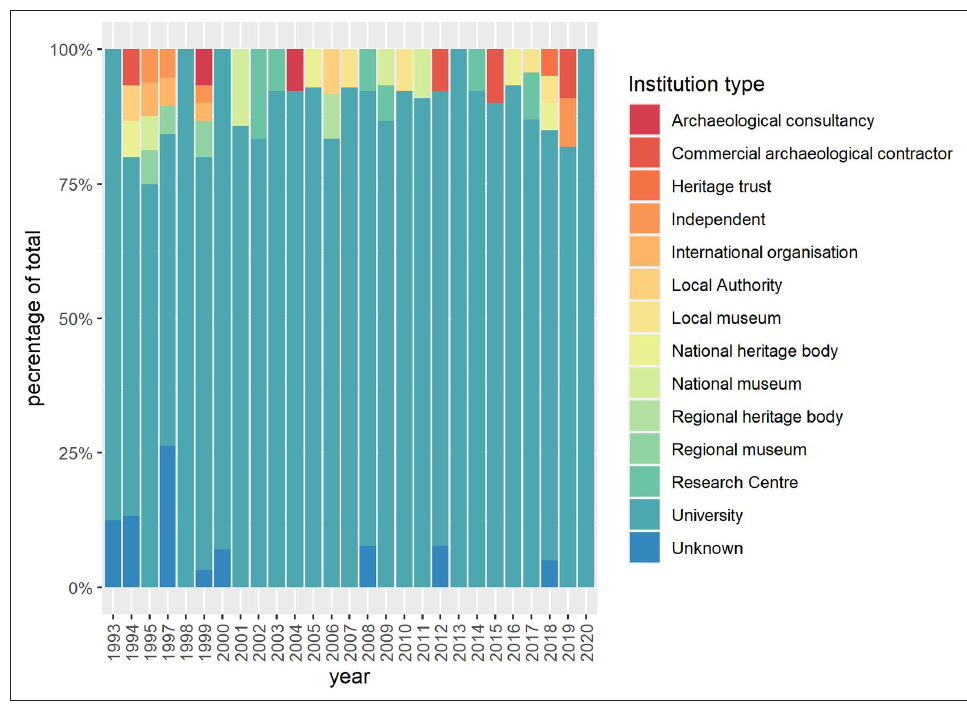
Figure 2: Institution types of publication authors (per